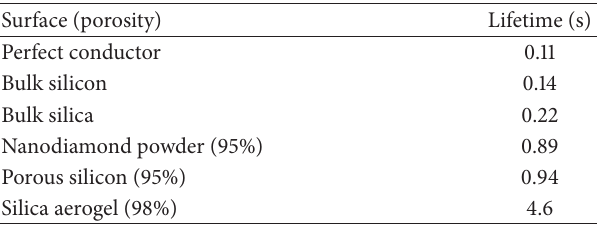
Table 1: The lifetime of the first gravitationally bound state of antihydrogen above various